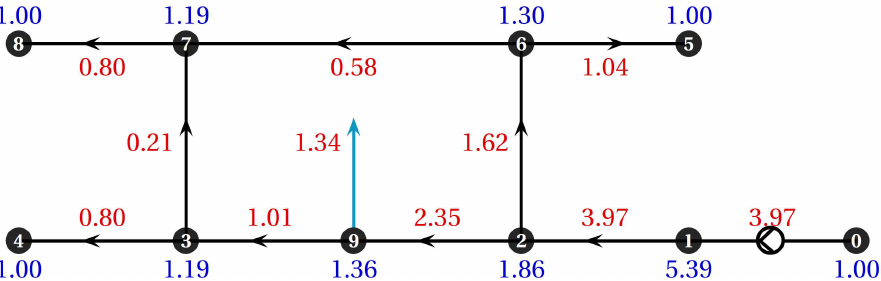
Figure 7. Pressures and flows in the network with a leakage in Node